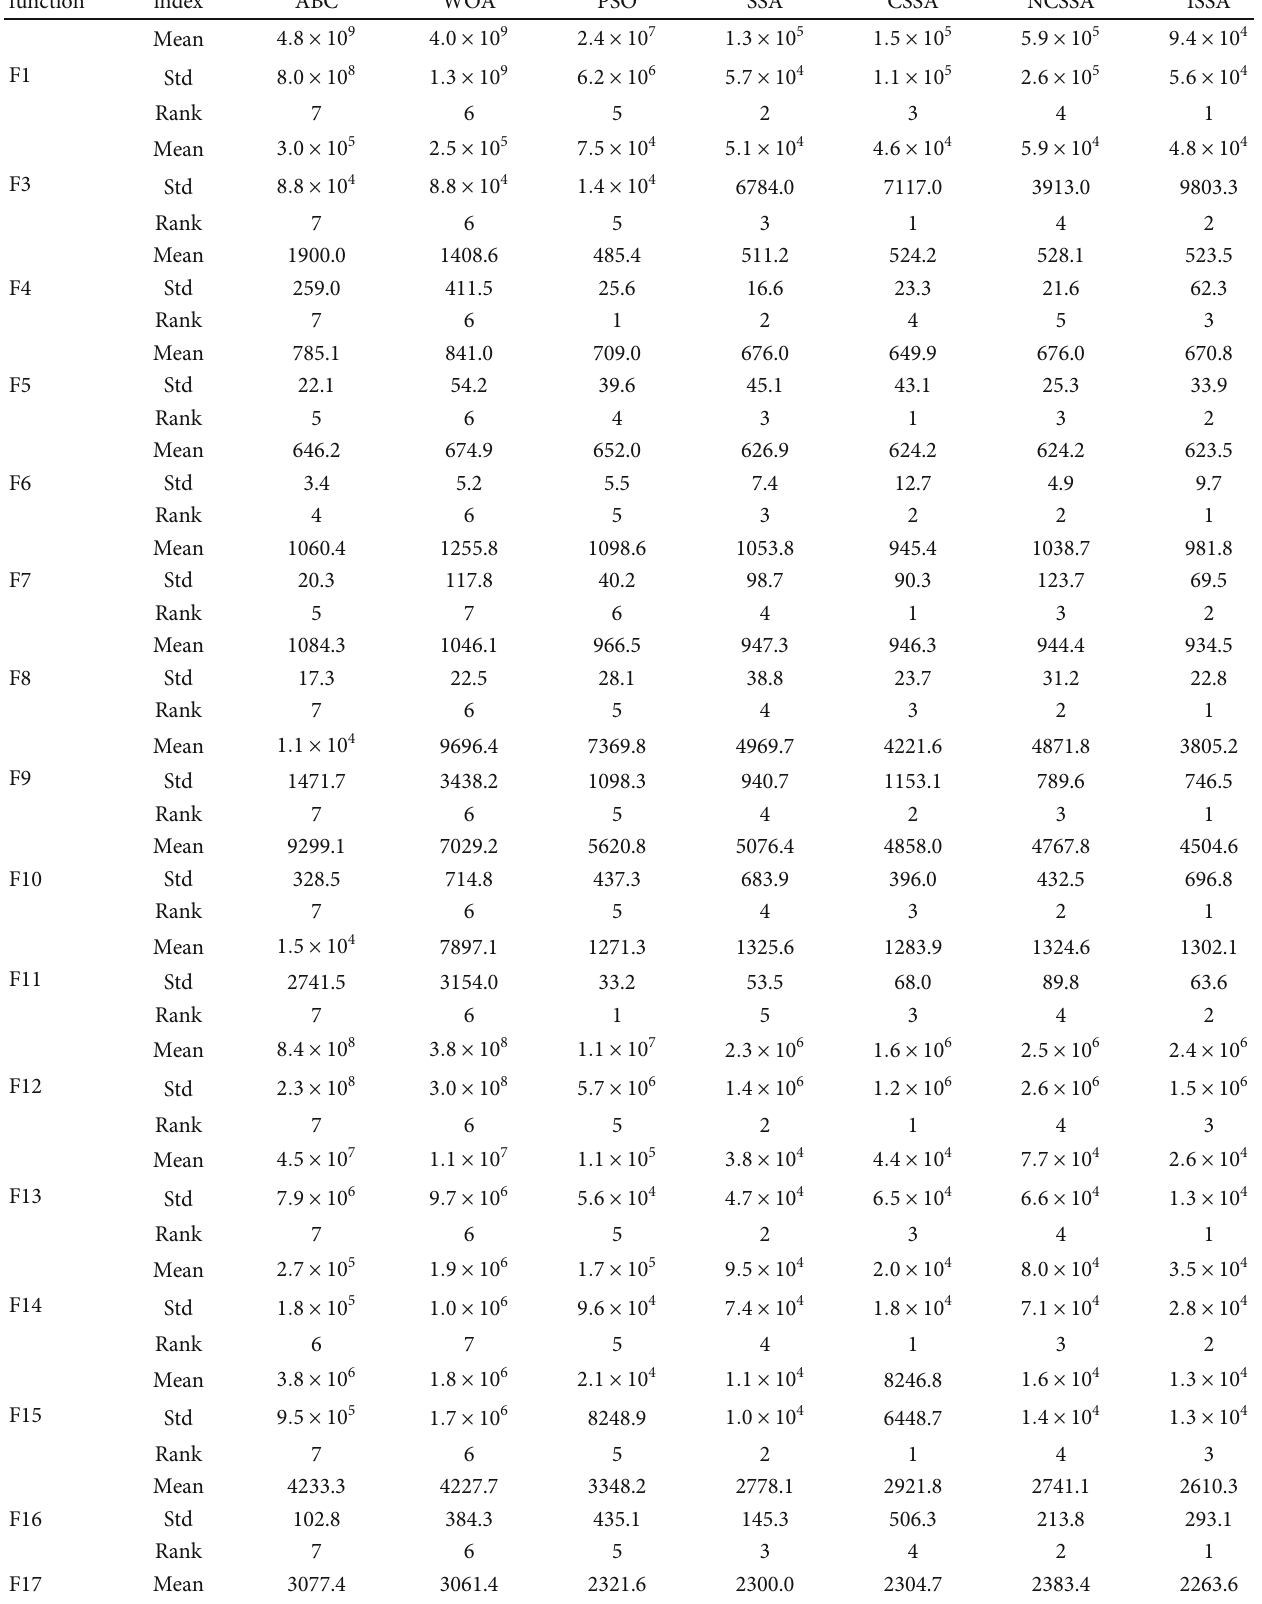
Table 3: Experimental results of 7 algorithms applied to CEC2017 test